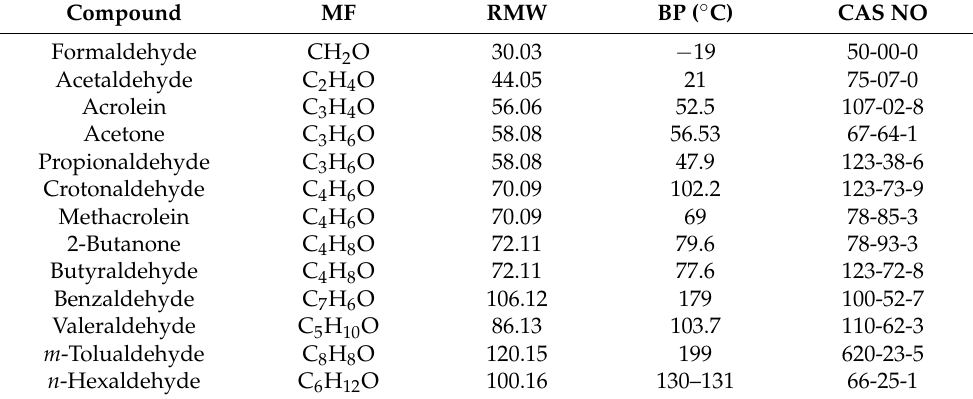
Table 2. Molecular formula and physical properties of target